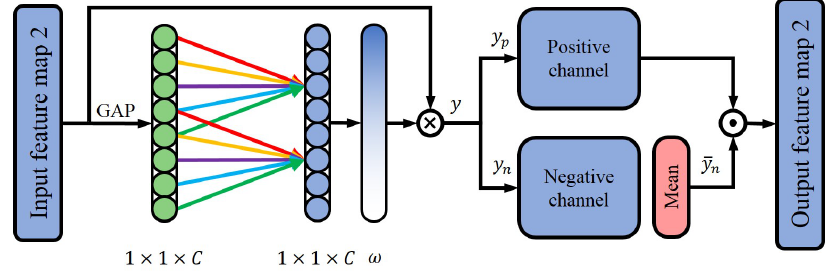
Figure 2. Structure of MFF